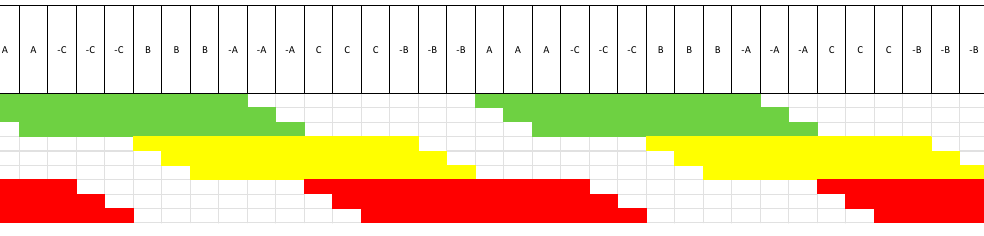
Figure 9. Copper rotor and E-engine prototype at no-load testing at 4017 rpm.